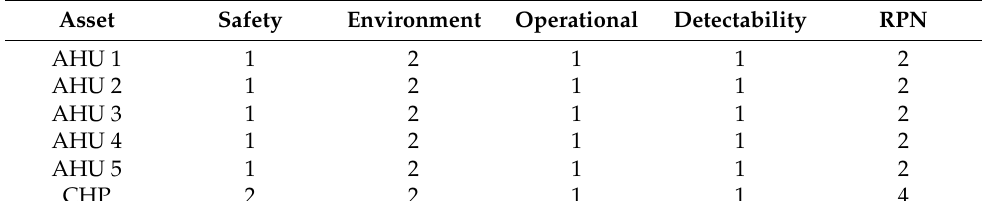
Table 6. Risk priority number assessment of selected assets categorised as level 1.